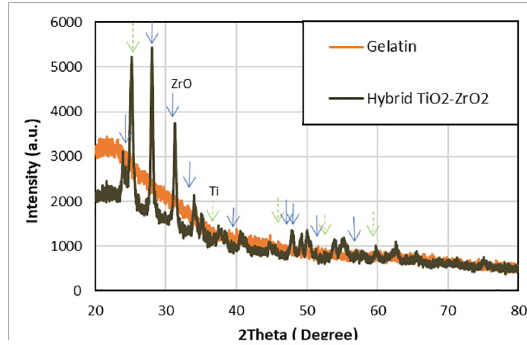
–ZrO (0.5:0.5) 2 2